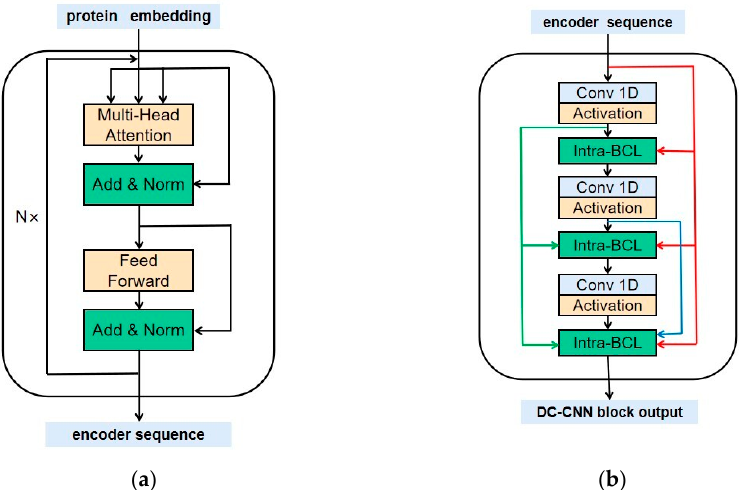
Figure 4. ( a ) The internal construction of an encoder. The encoder is connected by N coding layers